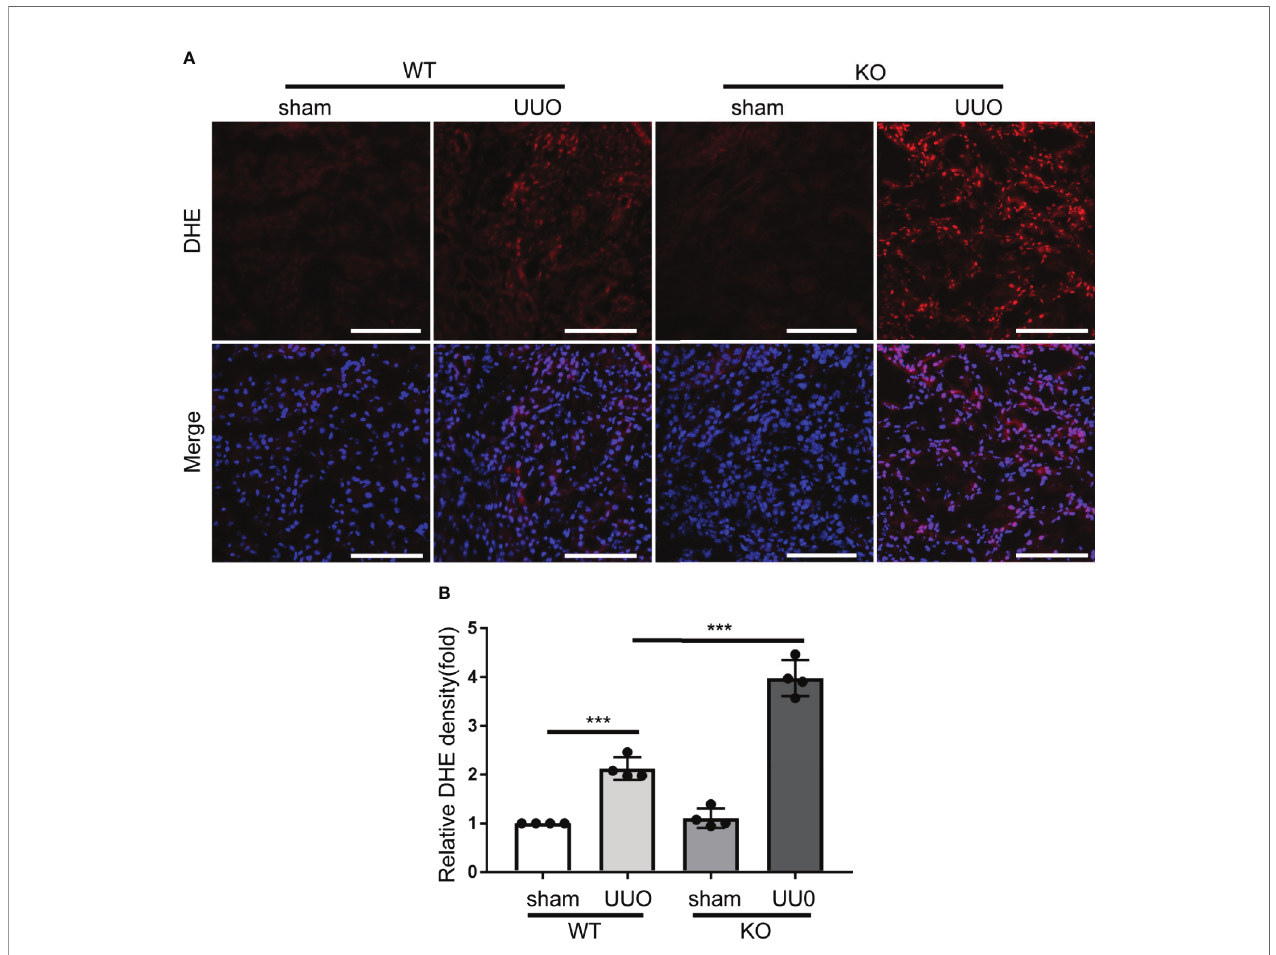
FIGURE 4 | Park7 de fi ciency accumulates ROS accumulation in renal tubular cells in UUO. Animals and their treatment were the same as described in Figure 2 . (A) Representative images of dihydroethidium (DHE) staining. DHE nuclear staining indicates the presence of reactive oxygen species(ROS). Bar:100 m m. (B) Quanti fi cation of DHE fl uorescence intensity (n=4). Each symbol (circle) represents an individual mouse. Error bars: SEM. ***p <